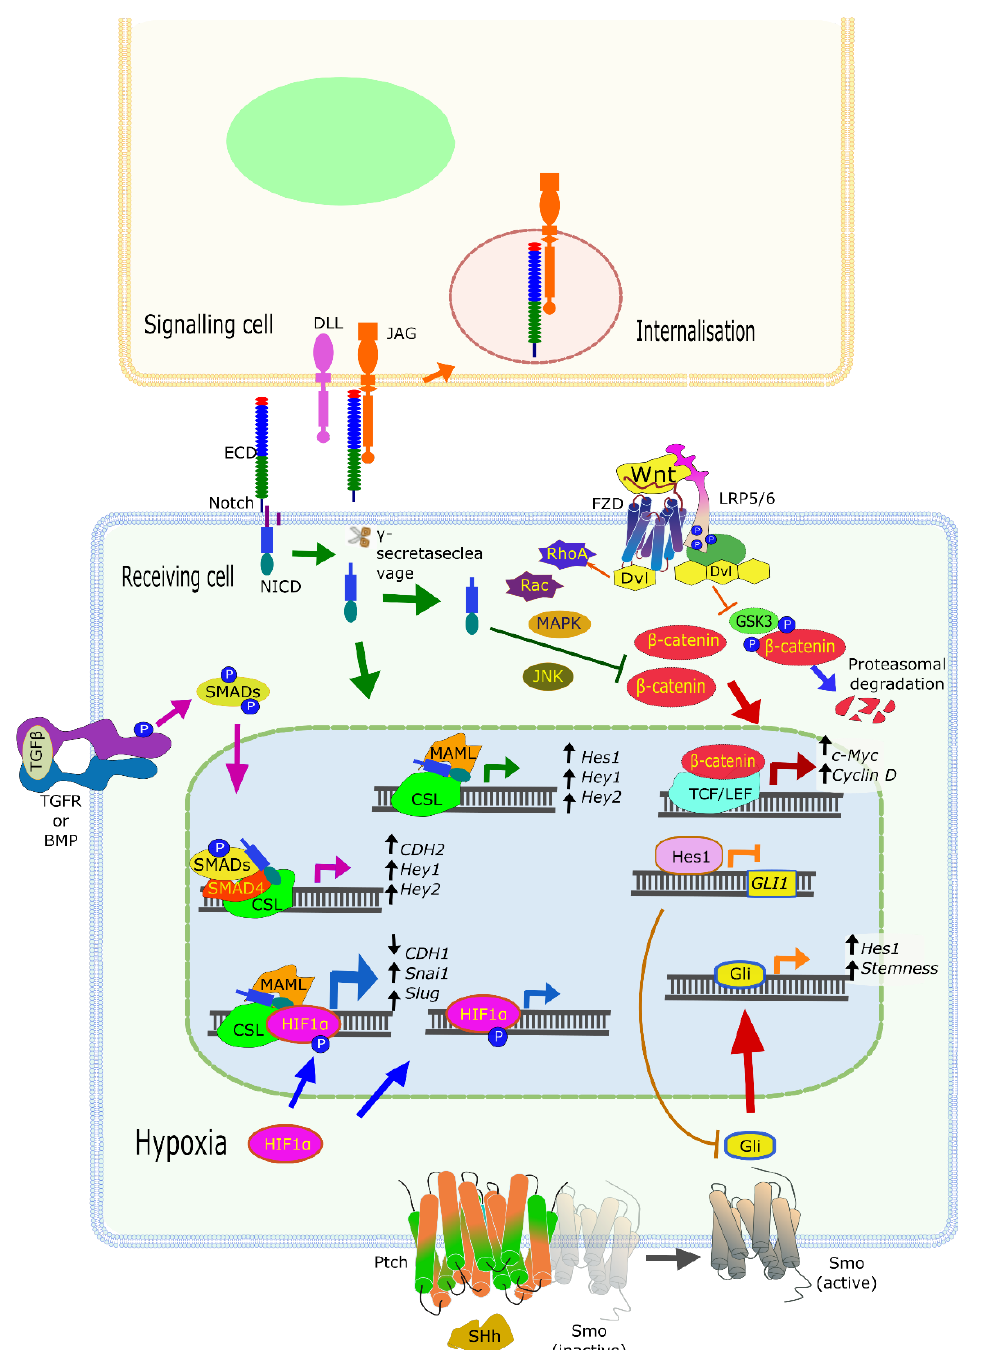
Figure 2. Notch crosstalk with other signaling pathways. Activation of Notch receptors by ligand-presenting cells results in the release of the Notch intracellular domain (NICD), forming a transcriptional activator complex with CBF1, Suppressor of Hairless, Lag-1 (CSL) and mastermind-like protein 1 (MAML). It also interacts with other signaling pathways, for example, by binding to β -catenin and inducing its degradation. The Wnt/ β -catenin pathway is involved in cell cycle regulation. NICD also interacts with hypoxia-inducible factor 1-alpha (HIF1a) during hypoxia enhancing HIF1a transactivating activity. Likewise, SMAD transcription factors, which are activated downstream the TGFR and BMP pathways, also interact with NICD/CSL complex. Interactions with additional pathways include communication with Sonic Hedgehog (SHH), where binding to Patched (Ptch) results in the release of Smoothened (Smo) and activation of a cascade of signaling centered in Gli. Hes1, a downstream target of Notch, represses GLI , while Gli activation by Smo triggers downstream genes such as HES1 and other stemness genes. Gene symbols used according to Genome Reference Consortium Human Build 37